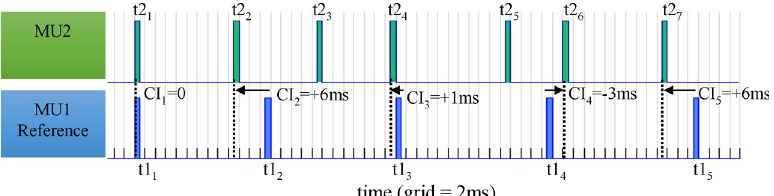
Fig 4. Illustration of the cross-interval measurements of pulses of real MU firing patterns {CI 1 , CI 2 , CI 3 , CI 4 , CI 5 }, considering MU1 as a reference (blue, bottom) and applying pairwise differences between the times of occurrences of all MU1 pulses { t 1 1 , t 1 2 , t 1 3 , t 1 4 , t 1 5 } and their corresponding closest neighboring pulse times of MU2 { t 2 1 , t 2 2 , t 2 4 , t 2 6 , t